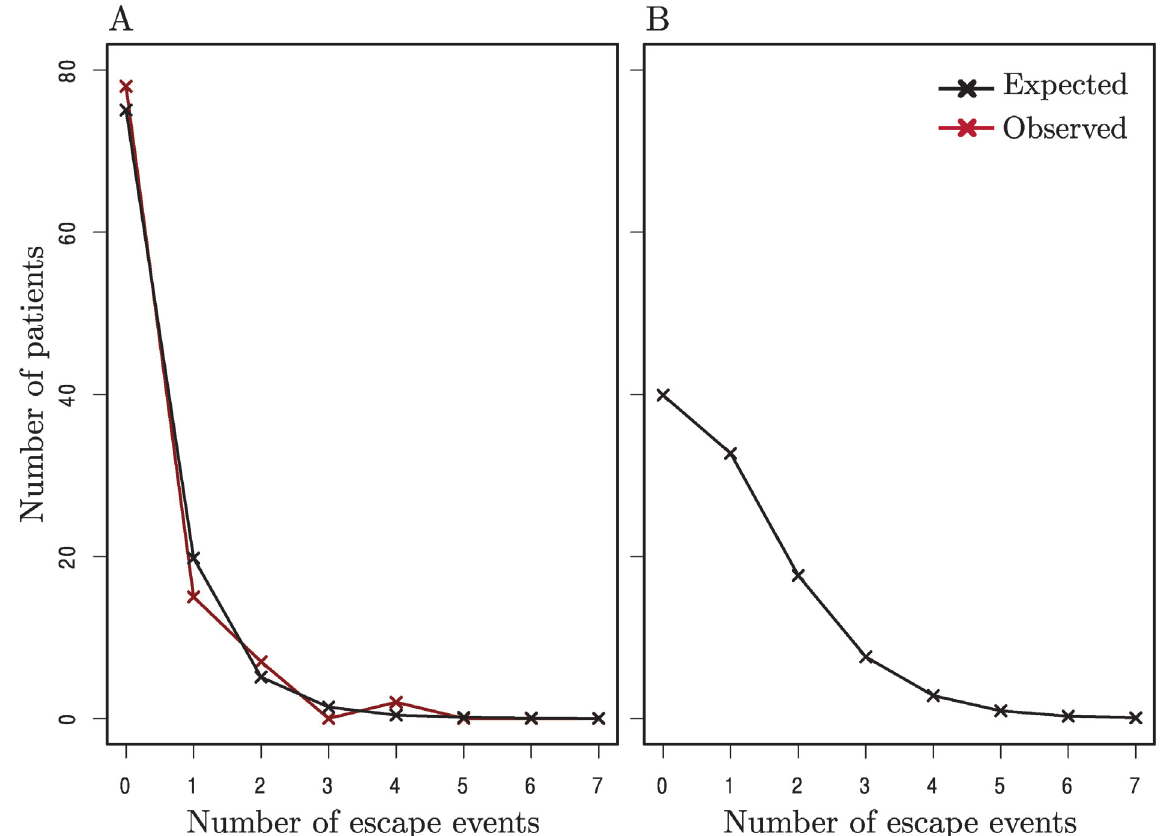
Figure 2. The distribution of incident escape across patients. (A) The observed distribution of incident escape (in HLA-matched patient-epitope pairs) across patients (red line) is similar to the distribution given by a Poisson process where the average rate of escape is constant across all patient-epitope pairs (black line). (B) The expected distribution of escape supposing all patients in (A) had a full set of sequence data and were observed for a full 2 years whilst off- ART. A goodness-of-fit test showed that there was no significant difference between the observed and expected distributions in (A) (p > 0.1). Details of calculations for the expected distributions are given in the